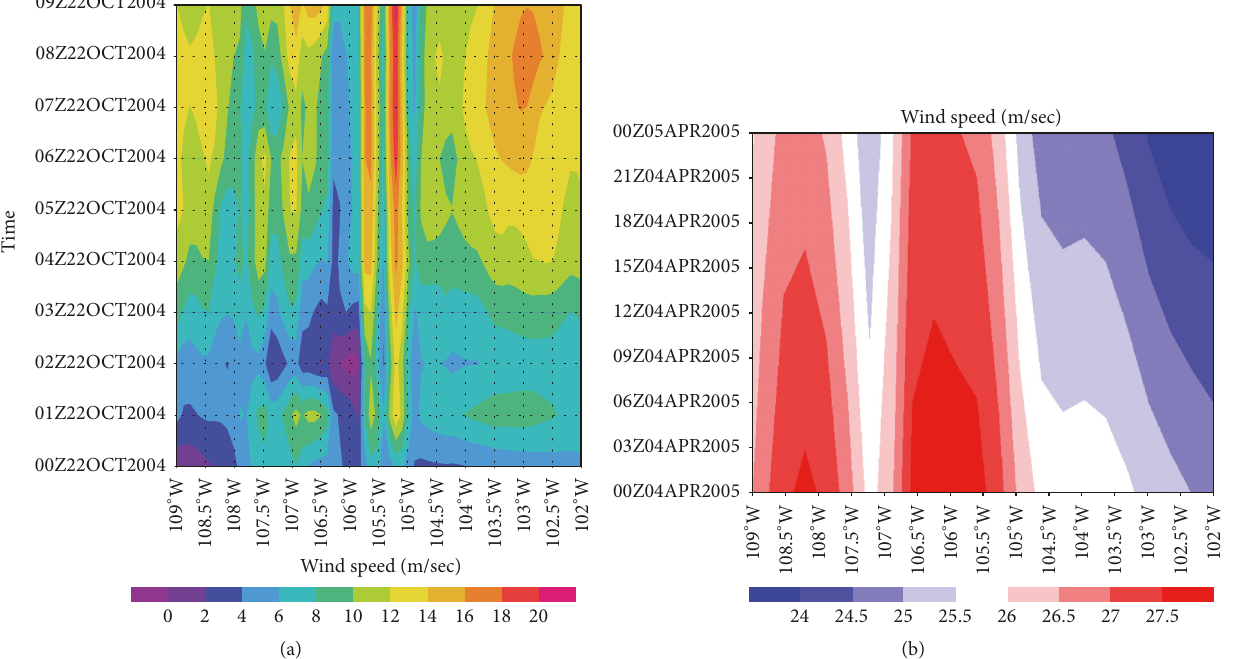
Figure 11: (a) 500 mb zonal wind speed for Case Study 1 (b). 500mb zonal wind speed for Case Study 2.